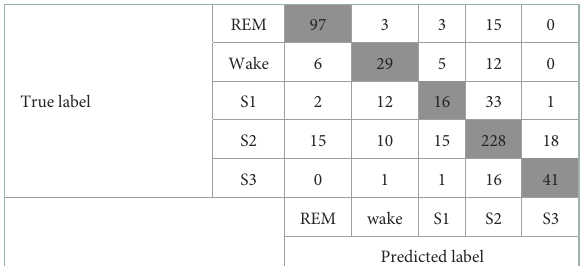
TABLE 4 Confusion matrix of the model that includes the Maxim raw features and the activity count-derived variables.